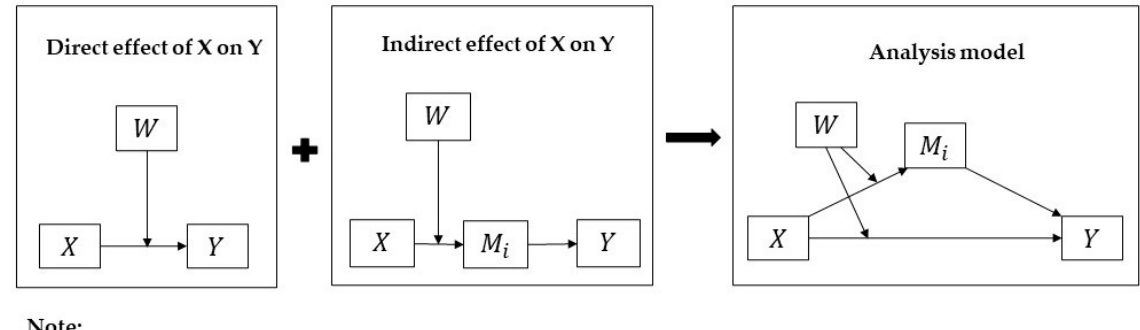
Figure 2. Research Figure 2. Research framework.